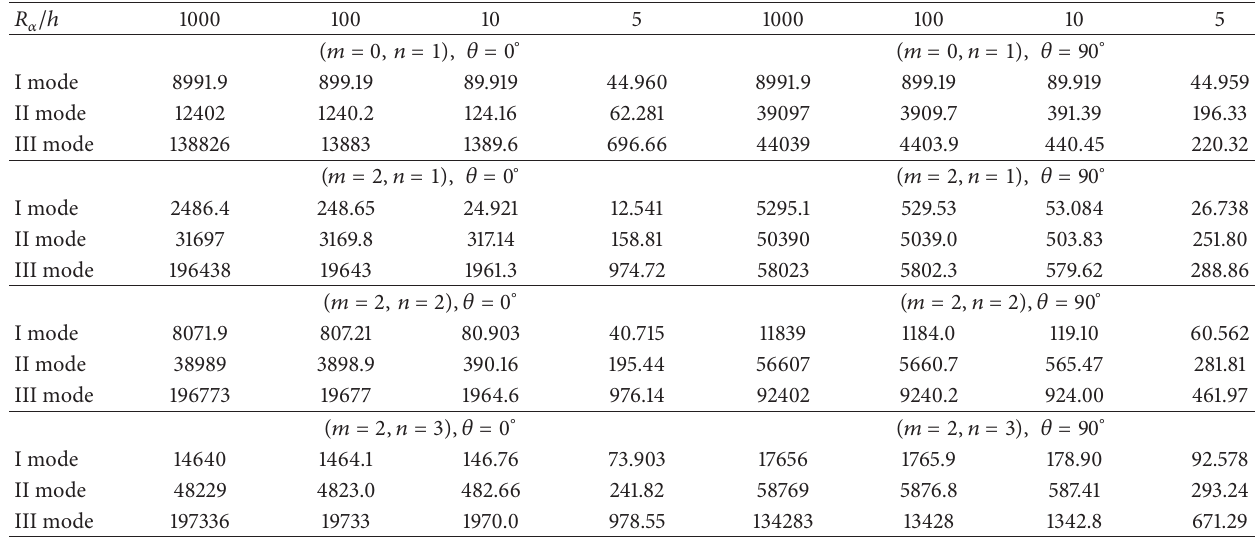
Table 12: Benchmark 8. Simply supported orthotropic cylinder. First three vibration modes in terms of no-dimensional circular frequency 𝜔 = 𝜔(𝑎 2 /ℎ)√𝜌/𝐸 𝑚 and 𝑛 . 𝑀 = 100 fictitious layers and 𝑁 = 3 order of expansion for the 2 for several combinations of half-wave numbers exponential